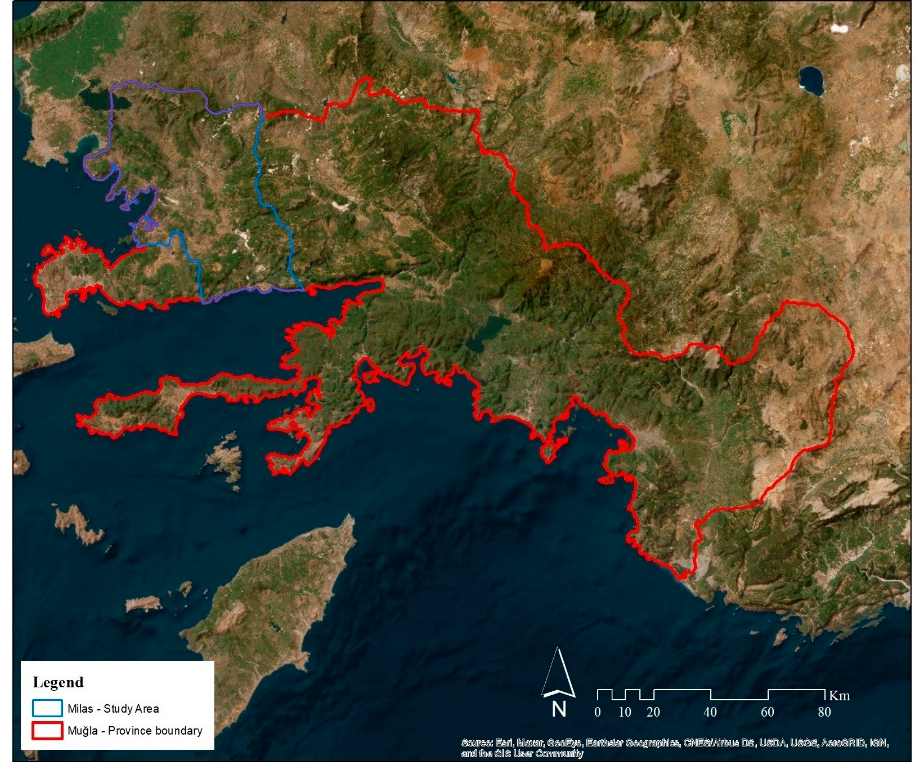
Figure 5. Milas district in Mu ğ la province boundary.